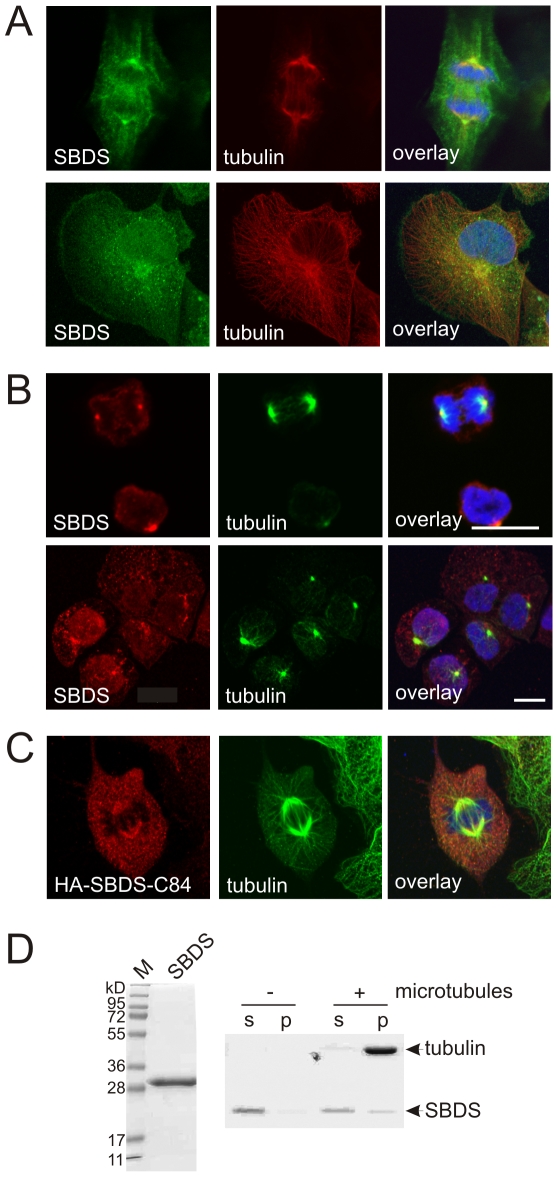
SBDS co-localizes with the MTOC and the mitotic spindle.Endogenously expressed SBDS co-localizes with the mitotic spindle and/or centrosomes (top panel) and the MTOC area (bottom panel) in (A) HeLa cells (n = 8) and in (B) cord blood CD34+ cells (n = 3). (C) Overexpressed HA-SBDS-C84 localizes to the mitotic spindle in U2OS cells (n = 5). (D) Recombinant expressed SBDS was used as a ligand in a microtubule-binding protein spin-down assay. Right panel shows a Coomassie-stained gel with 5 µg of the purified SBDS protein with a molecular weight of 30 kD. Left panel shows a Coomassie- stained gel with SBDS protein incubated in the presence or absence of microtubules, as indicated by tubulin staining. In the absence of microtubules, the SBDS protein remains in the soluble fraction (s) and in the presence of 0.16 nM taxol-stabilized microtubules, a small, but significant fraction of the SBDS protein co-precipitates with microtubules in the pellet (p) fraction. Representative result of 5 independent experiments.